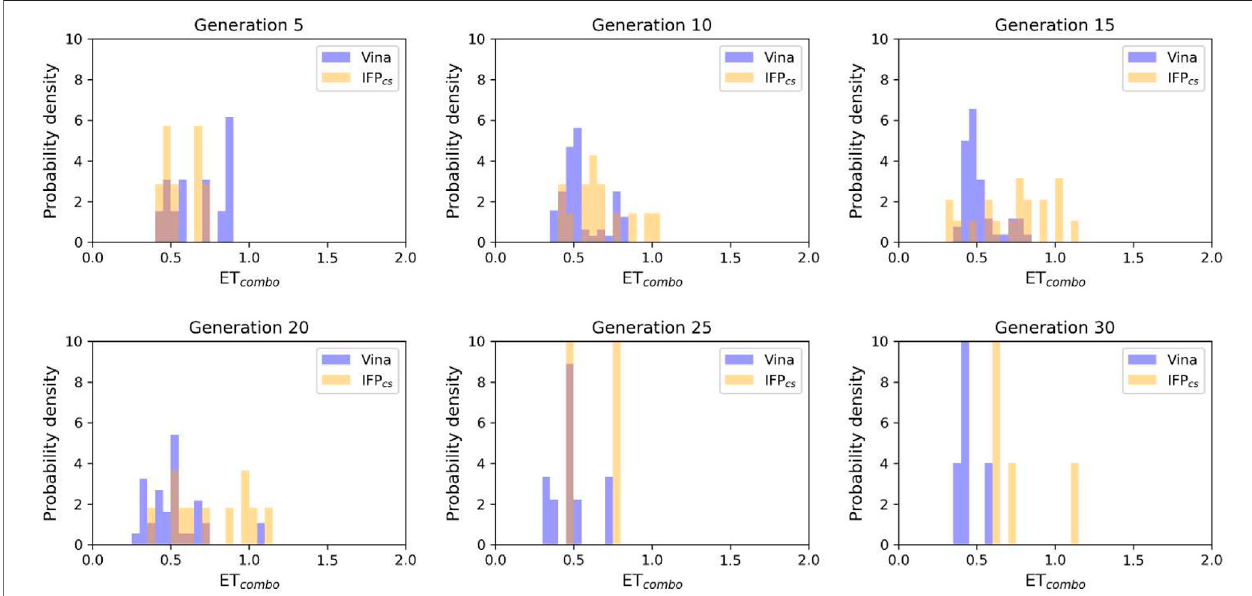
FIGURE 14 | The ability of the two Autogrow protocols in the prospective de novo run to produce compounds that have a high degree of similarity with regard to shape andelectrostaticpropertiestothecrystallographicligands, chosenasreference.Theprobabilitydistribution ofthe ET combo scoreforcompoundspopulatingeach generation is reported as a histogram, where the vertical axis reports the probability density while the horizontal axis reports the ET combo value. Two distributions are reported within each plot: the blue bars refer to compounds generated with the VINA protocol, while the orange bars refer to compounds generated with the IFP CS one.